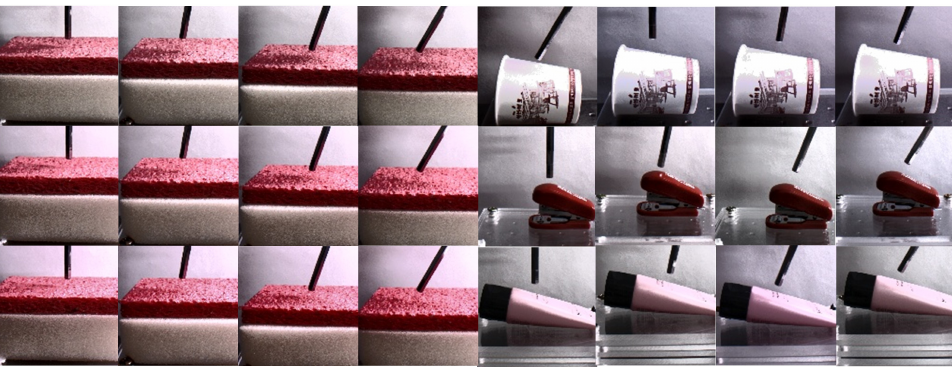
Figure 7. Dataset collected to estimate interaction